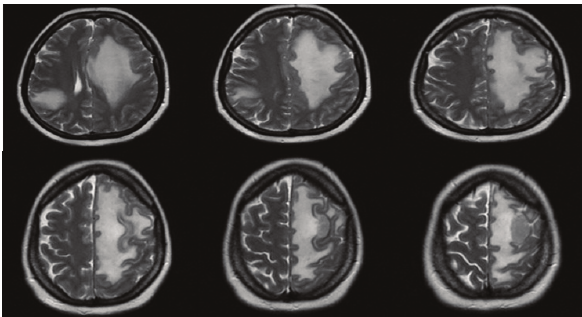
Figure 5: Brain magnetic resonance imaging revealing a metastatic lesion in the left frontoparietal lobe and peritumoral edema in the left frontopariteal and right parietal